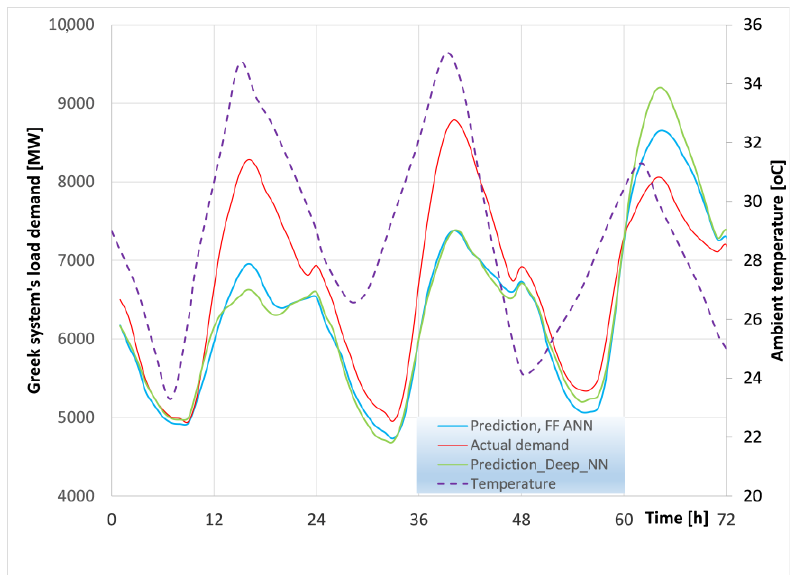
Figure 19. Incident of Saturday 16 – Monday 18 July: load prediction failure of both models during a weekend with high temperatures. Maximum relative error is −16.4% for the FF ANN and −19.9% for the deep NN.